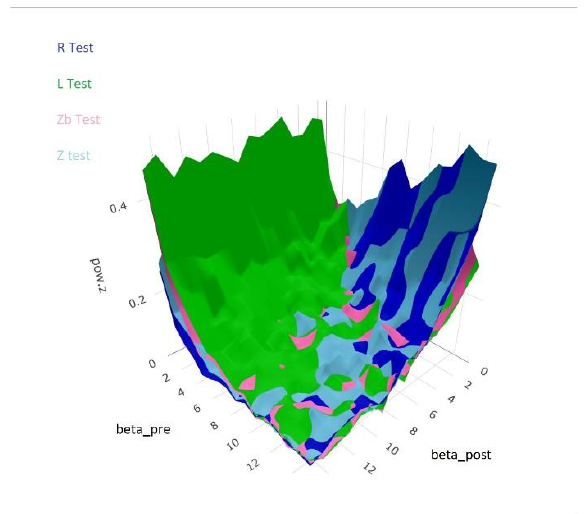
Fig. 2. Power study among Z , Z B , R , and L showing